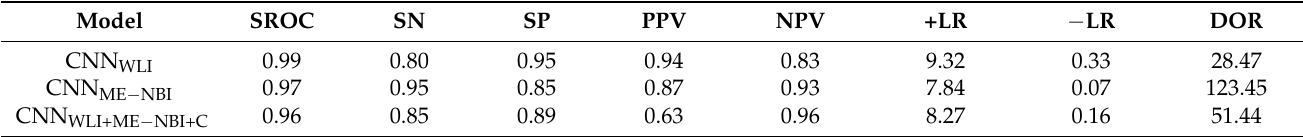
Figure 4. The AUROC curve for EGC detection. Table 3. The performance of the CNN model for EGC detection in different image modalities.